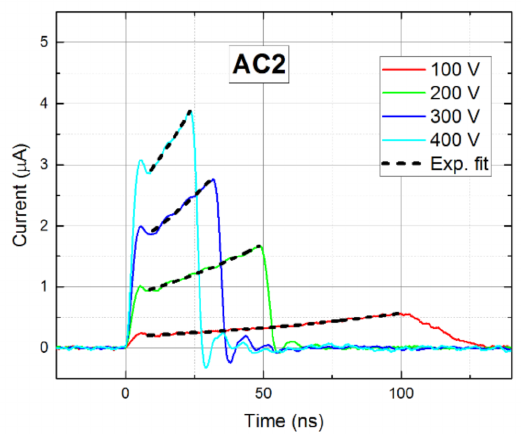
Figure 12. Exponential fits of waveforms measured in DB mode after 1 min biasing.